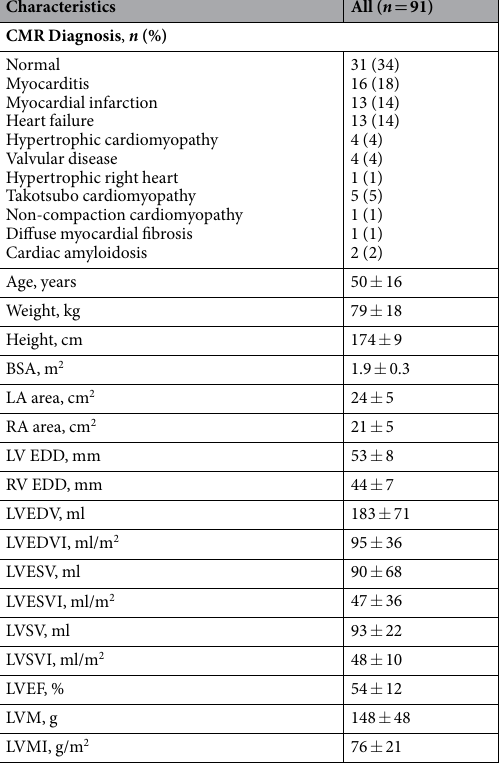
Table 1. Baseline characteristics for the study population. Data presented as mean ± standard deviation. BSA = body surface area, LA = left atrium; LVEDD = left ventricular end diastolic diameter, LVEDV = left ventricle end diastolic volume, LVESV = left ventricle end systolic volume, LVSV = left ventricle stroke volume, LVEF = left ventricle ejection fraction, LVM = left ventricular mass, RA = right atrium, RVEDD = right ventricular end diastolic diameter. An ‘I’ indicates volumes and mass indexed to